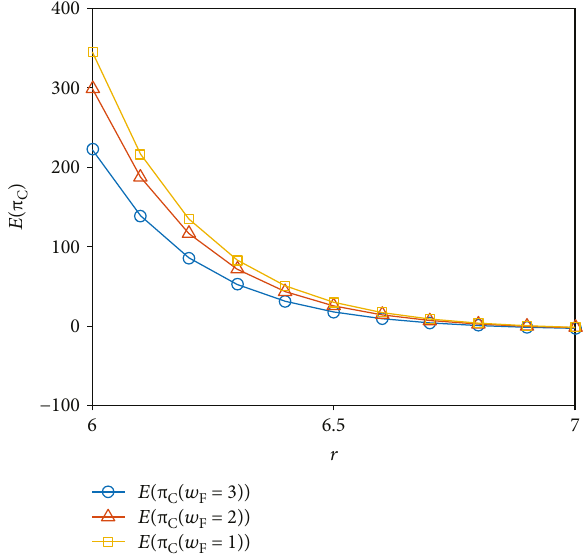
Figure 3: E ff ect of rainfall on the company ’ s performance under di ff erent reservation price.